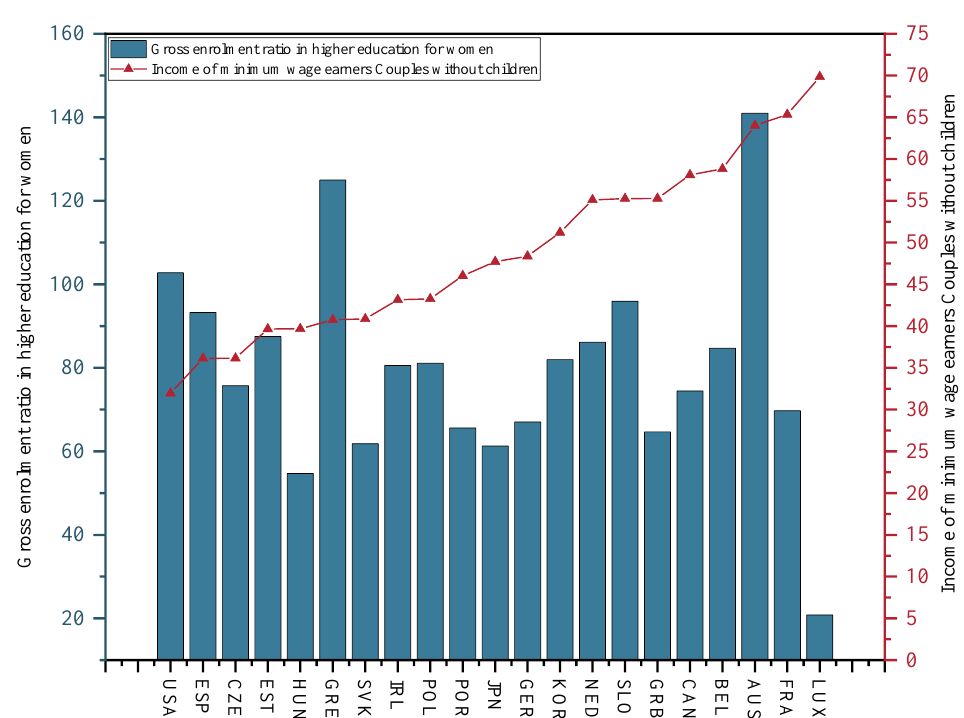
Figure 12. Gross enrolment ratio in higher education for women and the income of minimum wage-earning couples without children in the selected OECD countries in 2015.